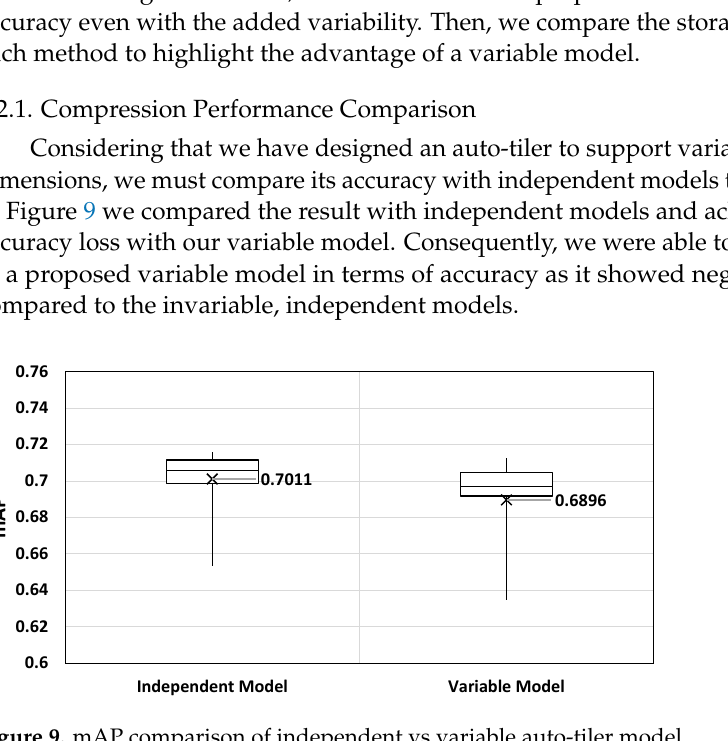
Figure 9. mAP comparison of independent vs variable auto-tiler model.